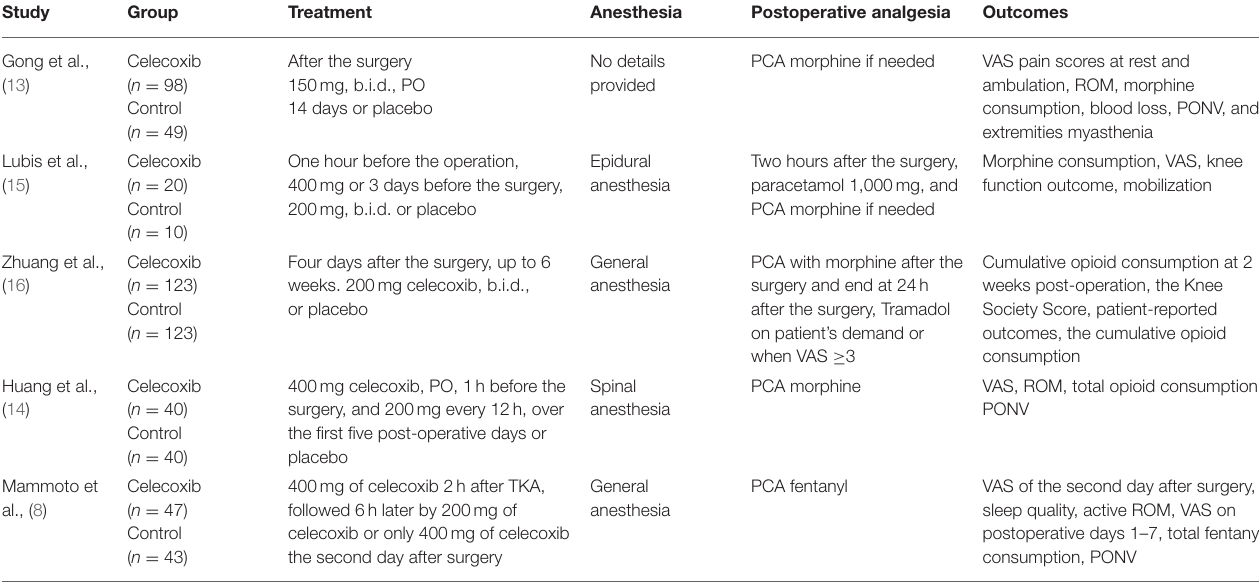
TABLE 1 | Characteristics of the included